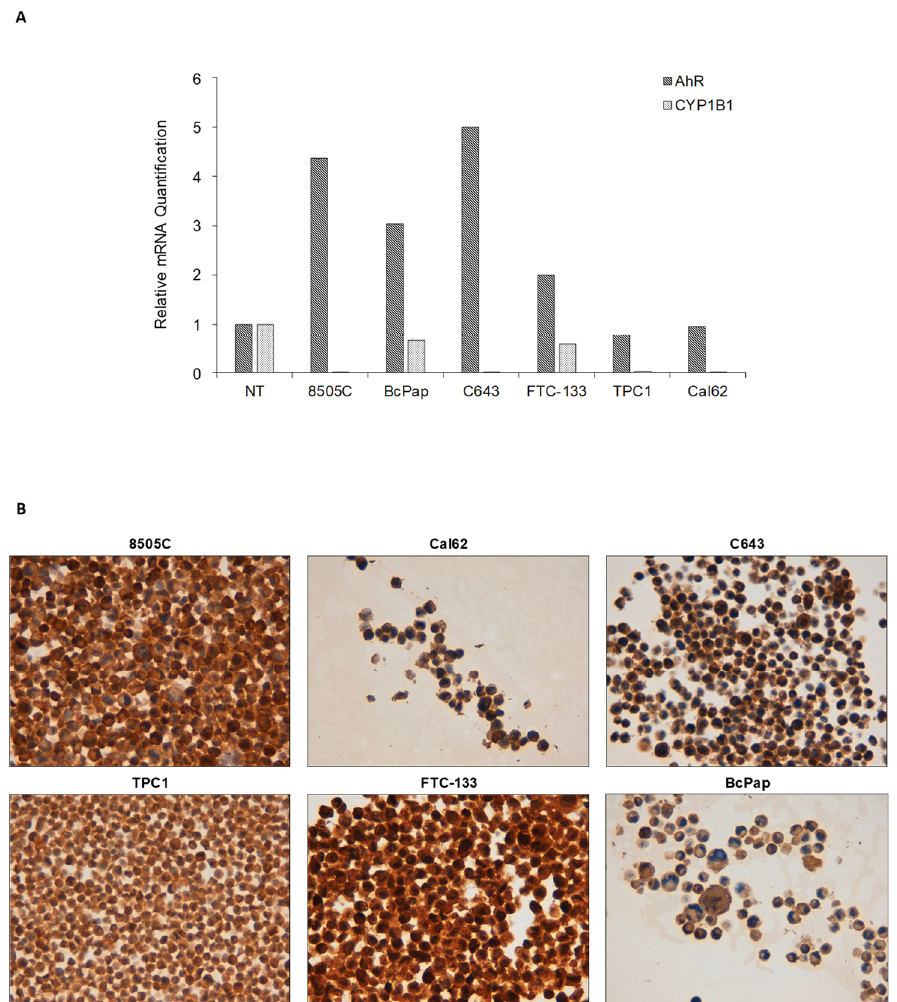
Figure 3. AhR expression in thyroid cancer cell lines. ( A ) After total RNA extraction from thyroid cancer cell lines and cDNA synthesis, AhR and CYP1B1 mRNA expressions were evaluated by qPCR. The data are presented as means of RQ obtained normalizing the acquired data with those of the normal thyroid sample. Only FTC-133 and BcPap cell lines showed detectable CYP1B1 mRNA, although lower than normal thyroid. ( B ) AhR expression was evaluated by ICC on cell pellets using a primary monoclonal anti-human AhR antibody. Immunostaining showed that AhR was localized prevalently in the cytoplasm in all the cell lines except for FTC-133 where a simultaneous cytoplasmic and nuclear staining was detected. Magnification: 400 ×